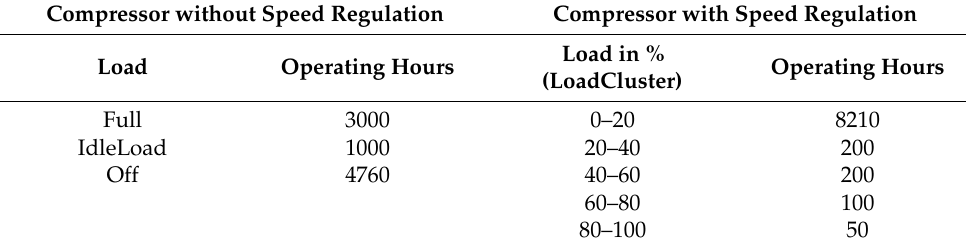
Examples of how operating hours are displayed on compressor screens (source: own